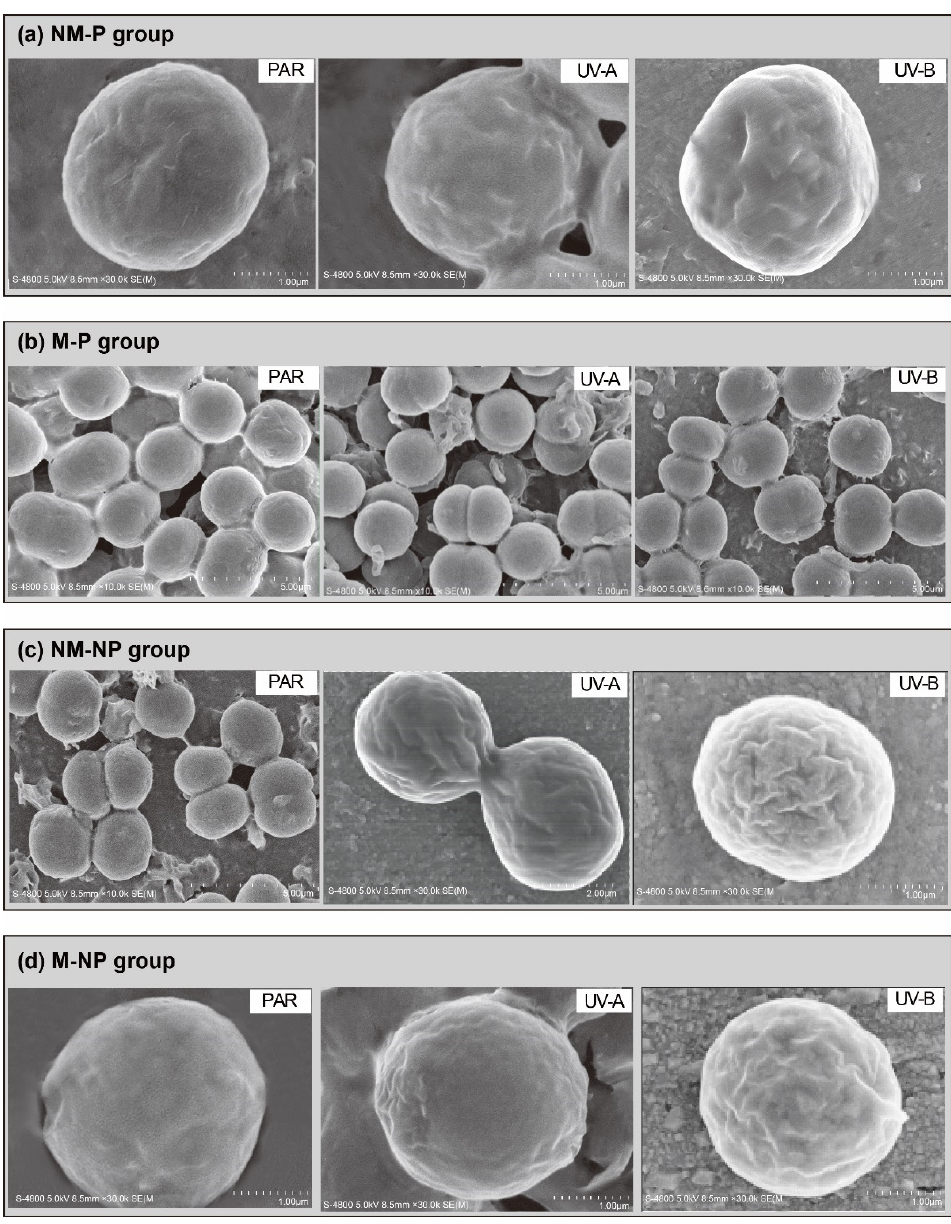
Figure 5. SEM images of M. aeruginosa cells on Day 1 in ( a ) NM-P group, ( b ) M-P group, ( c ) NM-NP group and ( d ) M-NP group after 5 h of different irradiation.